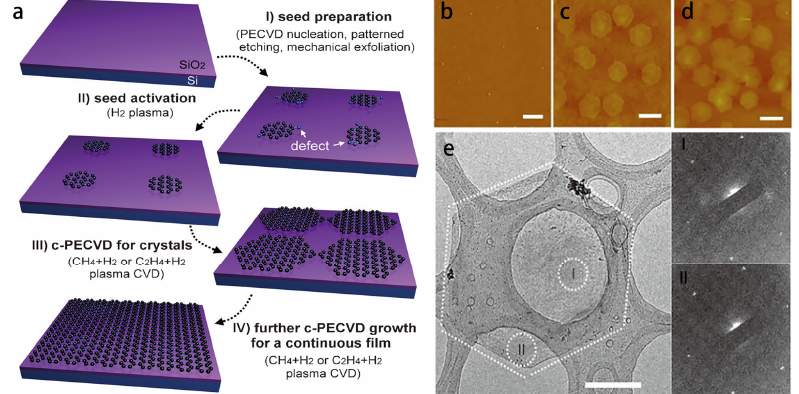
Figure 7. Graphene growth in a remote radio frequency (RF) PECVD system. ( a ) Graphene preparation flow; ( b ) AFM images of graphite agglomerates after nucleation at 650 °C; ( c , d ) AFM images of graphene on SiO 2 /Si after c-PECVD (CH 4 + H 2 ) growth at 600 °C for 90 min ( c ) and 120 min ( d ); ( e ) TEM image of graphene highlighted with a dashed line. The two images on the right are electron diffraction images of selected areas in the region shown by the dashed line [41].